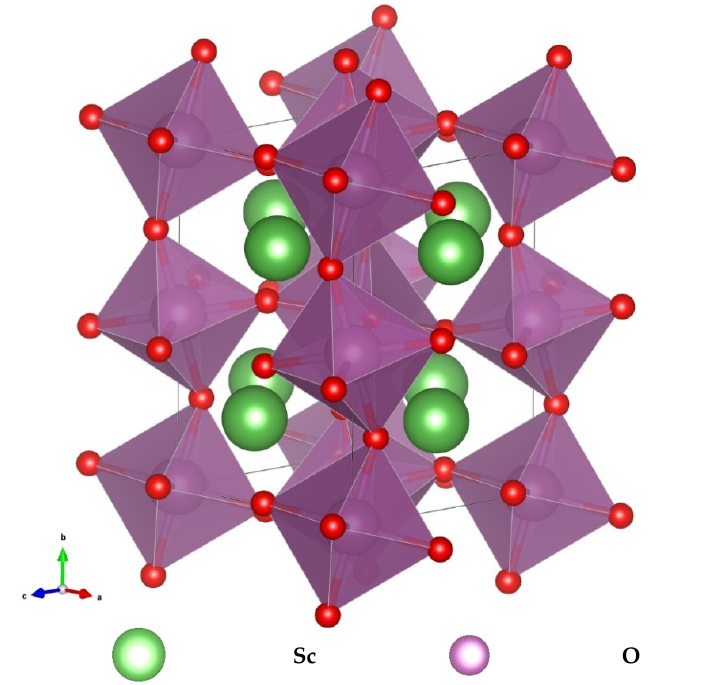
Figure A1. Optimized crystal structure of LaScO 3 .